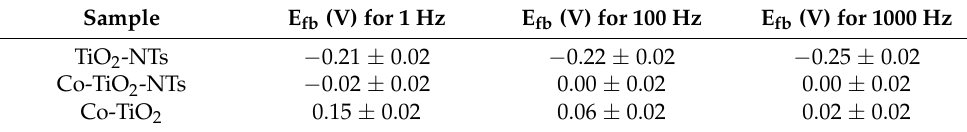
Table 2. Flat band potential values for selected frequency for pure and Co-doped TiO 2 samples.